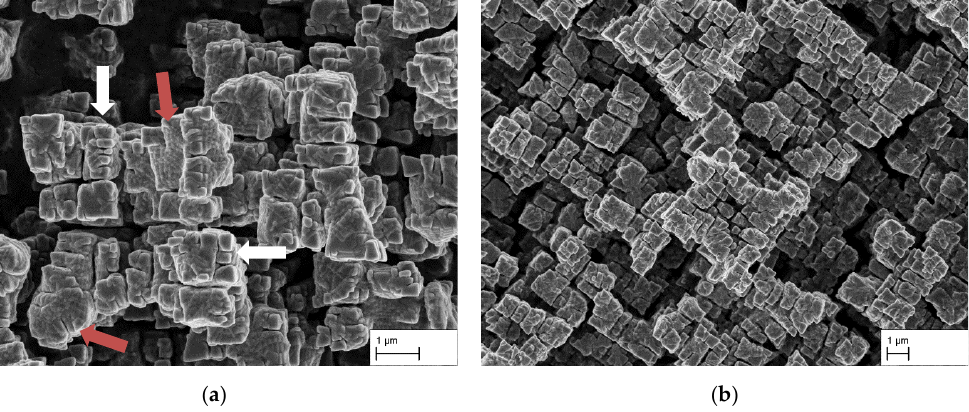
Figure 6. Large and closely adjacent γ’ -precipitates in deeply etched specimens; ( a ) 975 °C — neigh- boring particles that have grown together at their arms. Both, large areas with steps at the interfaces (see red arrows) and fine coherent parts (see white arrows) can be seen; ( b ) 900 °C — blocky, less in <111>-direction elongated, precipitates with clearly visible matrix channels between the individual particles.